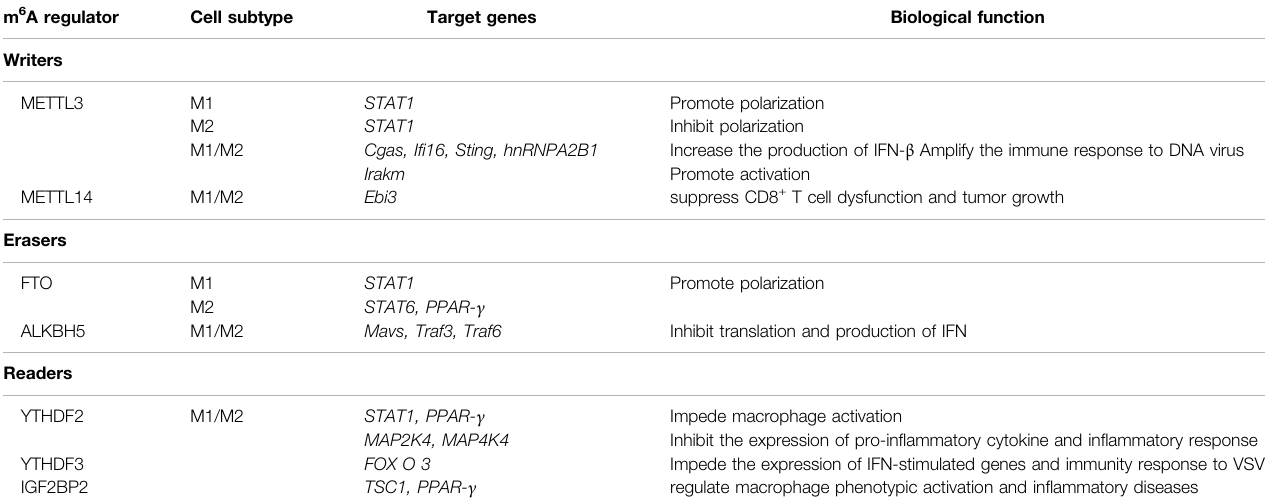
TABLE 1 | Roles of m 6 A Writers, Erasers, and Readers in